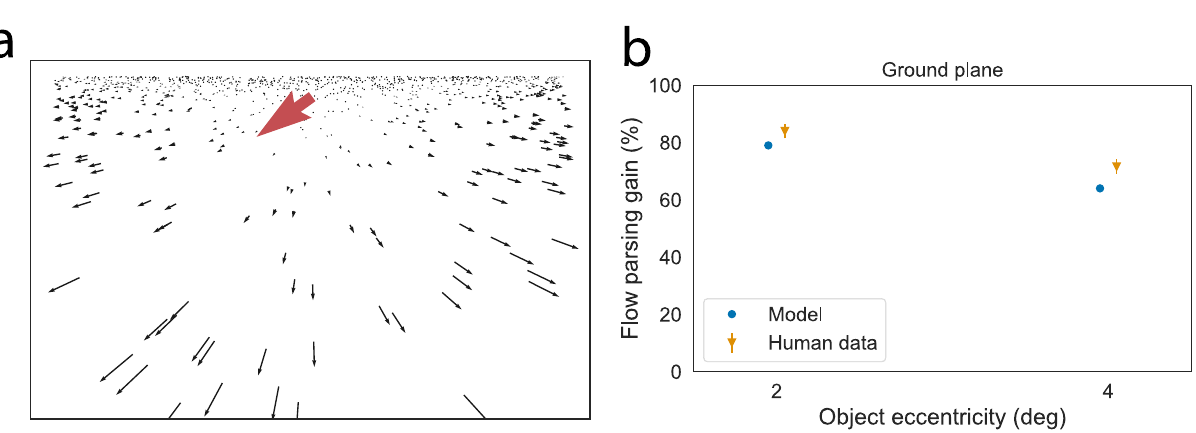
Fig 7. (a) Optic flow from the ground plane scenario used in Simulation 2. The red arrow shows the observer-relative motion of a small moving object. We scaled the length of the object vector 3x for visibility. (b) Model and human flow parsing gains. Error bars denote